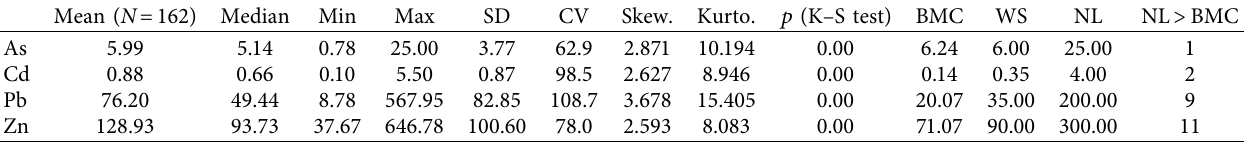
Table 3: Statistical summary of metal(loid) concentrations (mg/kg) in agricultural soils of the study area. Mean ( N � 162)